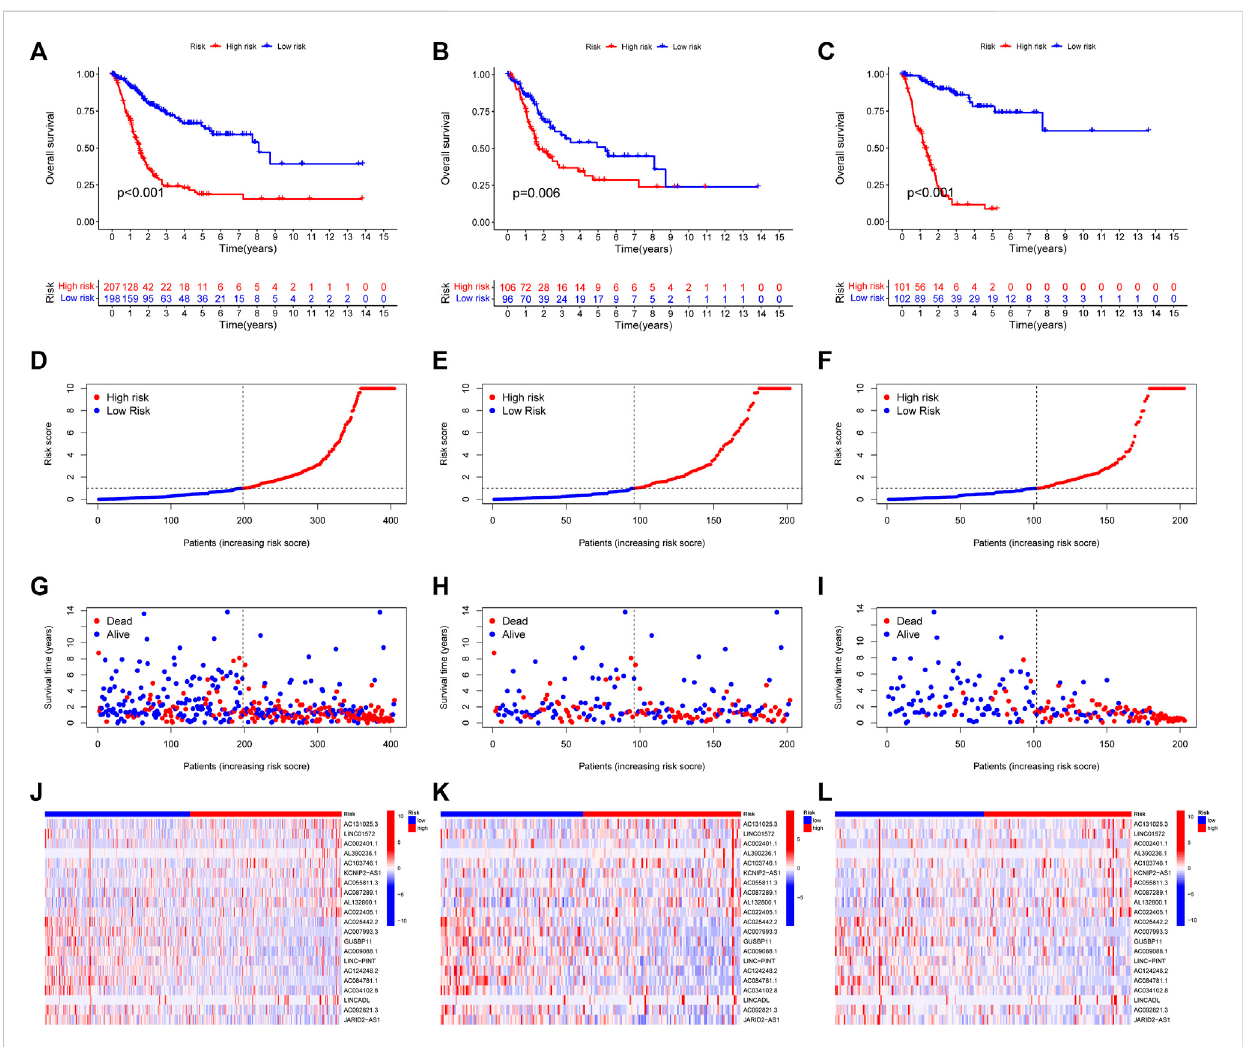
FIGURE 3 CoInternal validation for CupRLSig model overall survival determination for the all, train and test TCGA-BLCA groups. Prognosis of the risk model in differentgroups.Kaplan – MeiersurvivalcurvesofoverallsurvivalofBLCApatients (A – C) ,Thedistributionofoverallsurvivalriskscores (D – F) ,survivaltime and survival status (G – I) , heatmaps of 21 lncRNA expressions (J – L) . Red and blue dots indicate death and survival,